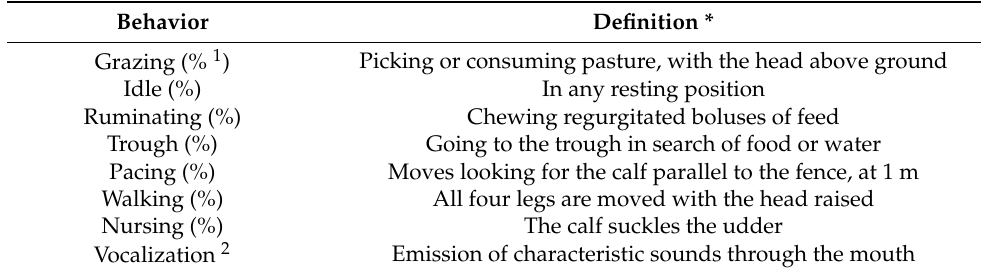
Table 1. Description of observed cattle behaviors in